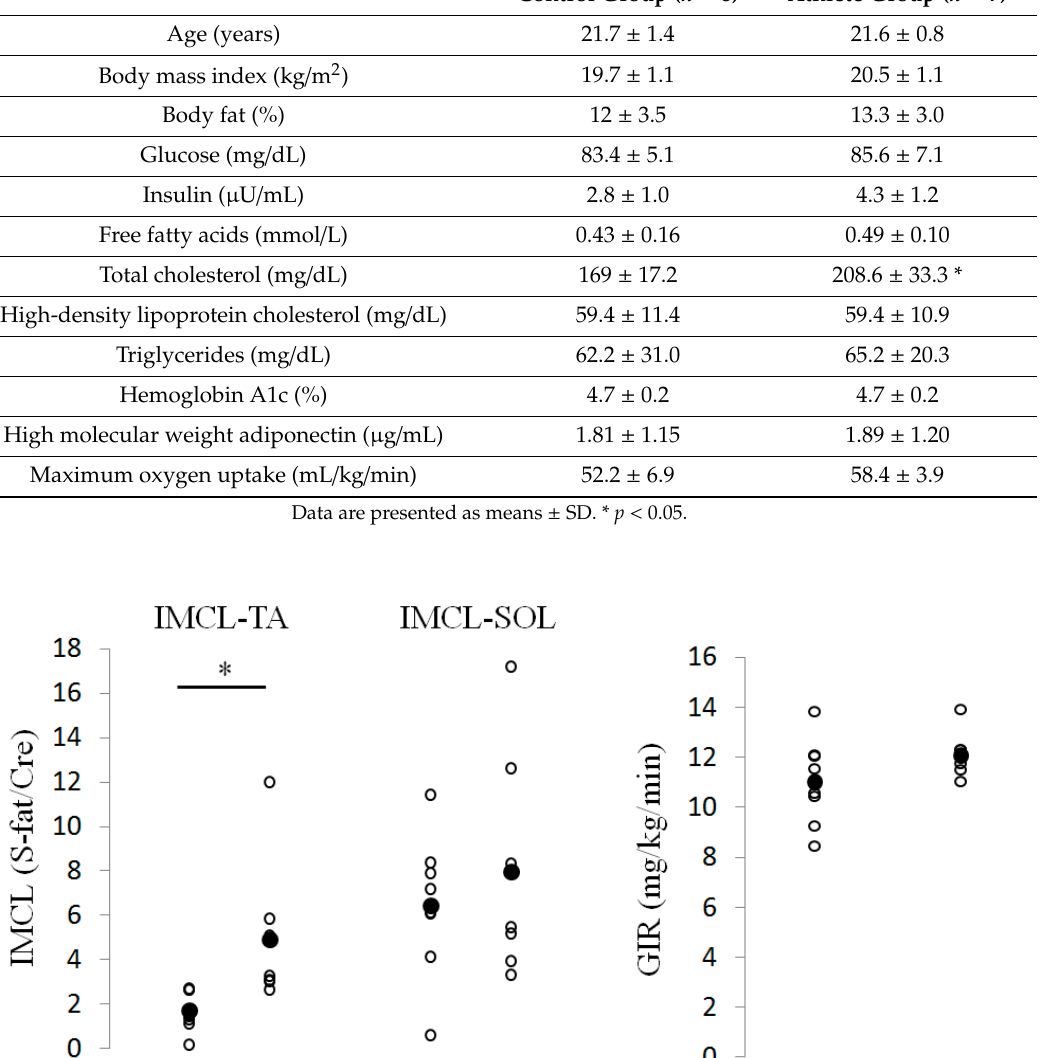
Table 1. Characteristics of the control and athlete groups.